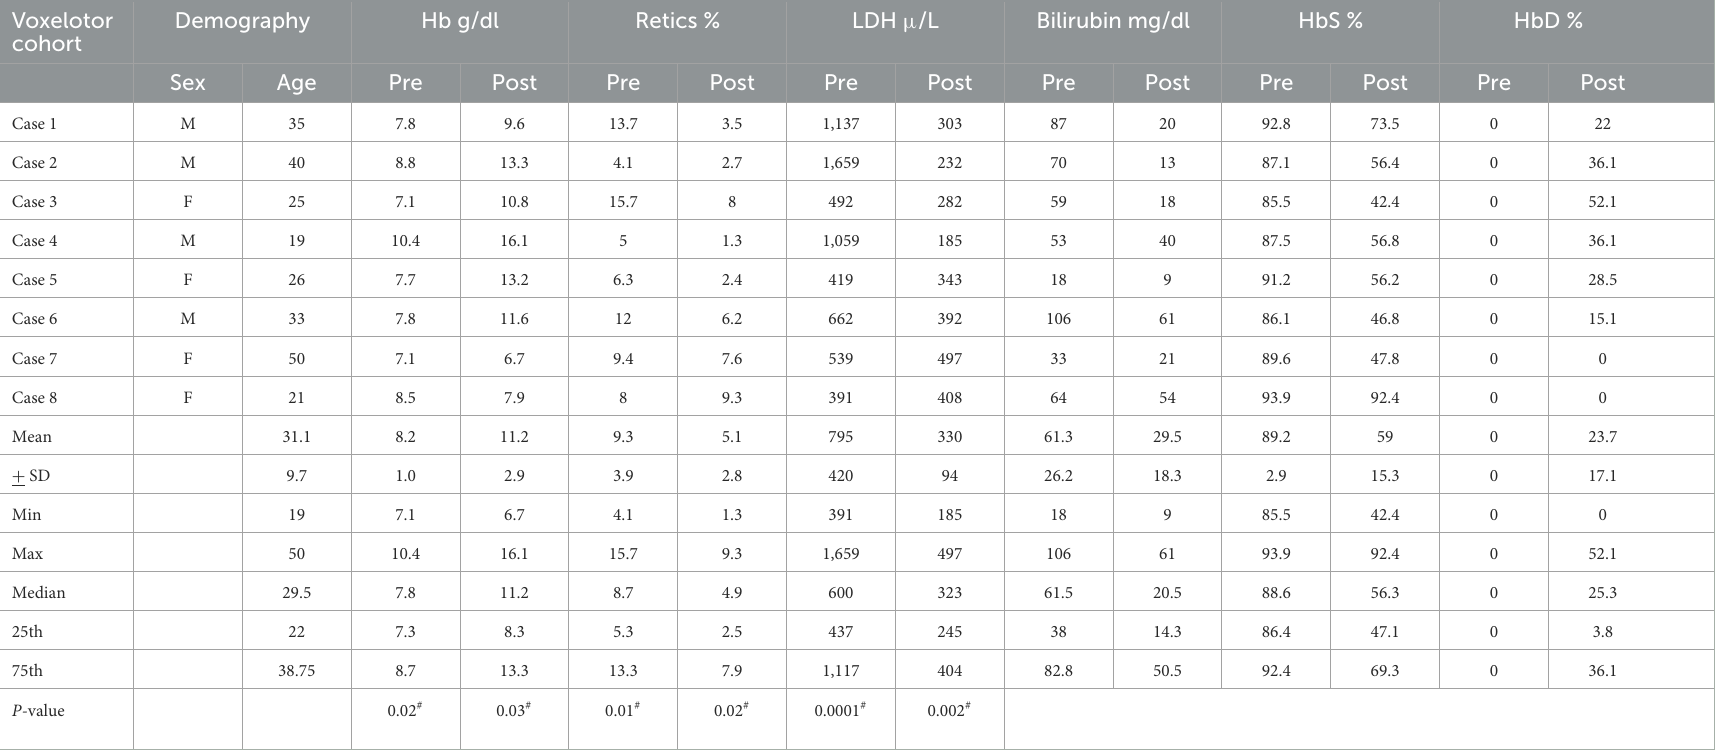
TABLE 1 Demography and laboratory parameters in SCD cohort on